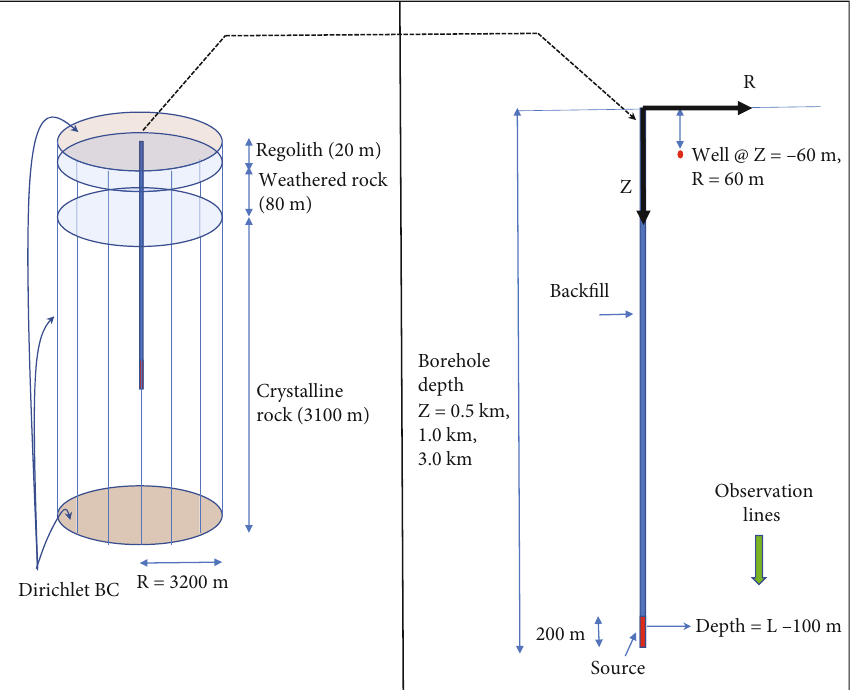
), di ff usion ( L ), and advection ( L H D